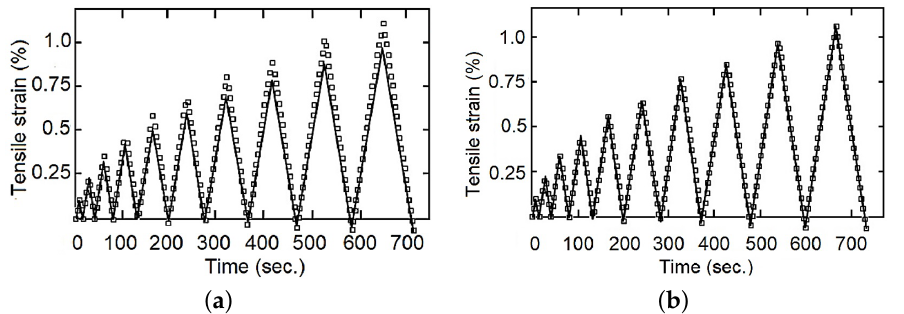
Figure 7. Tensile strain for loading–unloading test, one specimen with 0 wt%, experimental data in dots and model response in continuous line, ( a ) integer index model, ( b ) fractional index model.